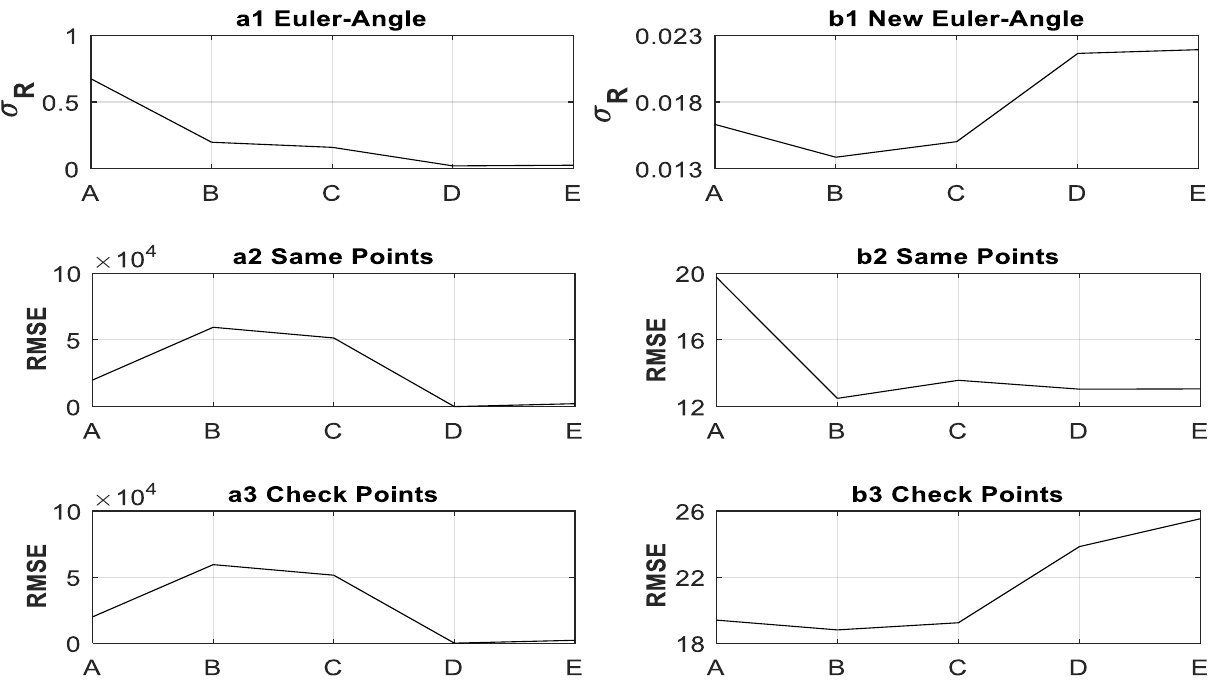
Figure 5. Transformation precision comparison of the EA-Method and NEA-Method for practical engineering application (each x axis value represents a different case selection of the common points, each y axis value represents a different precision for a different precision index ( σ R (rad), RMSE (mm)), ( a1 – a3 ) shows the results of the EA-Method, ( b1 – b3 ) shows the results of the NEA-Method).